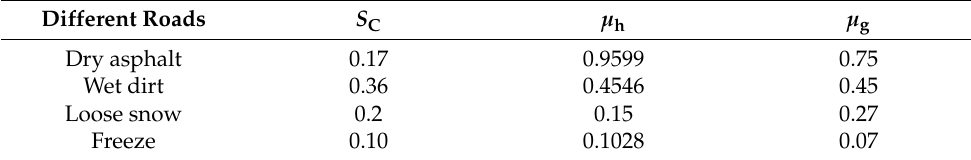
Figure 6. Linearization of the slip rate curve. Table 1. Ground adhesion coefficients of different